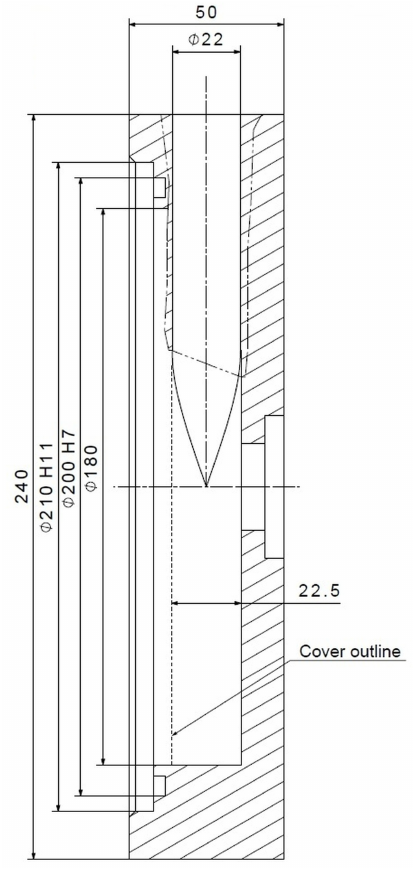
Figure 3: Dimensions of base annular casing of model pump